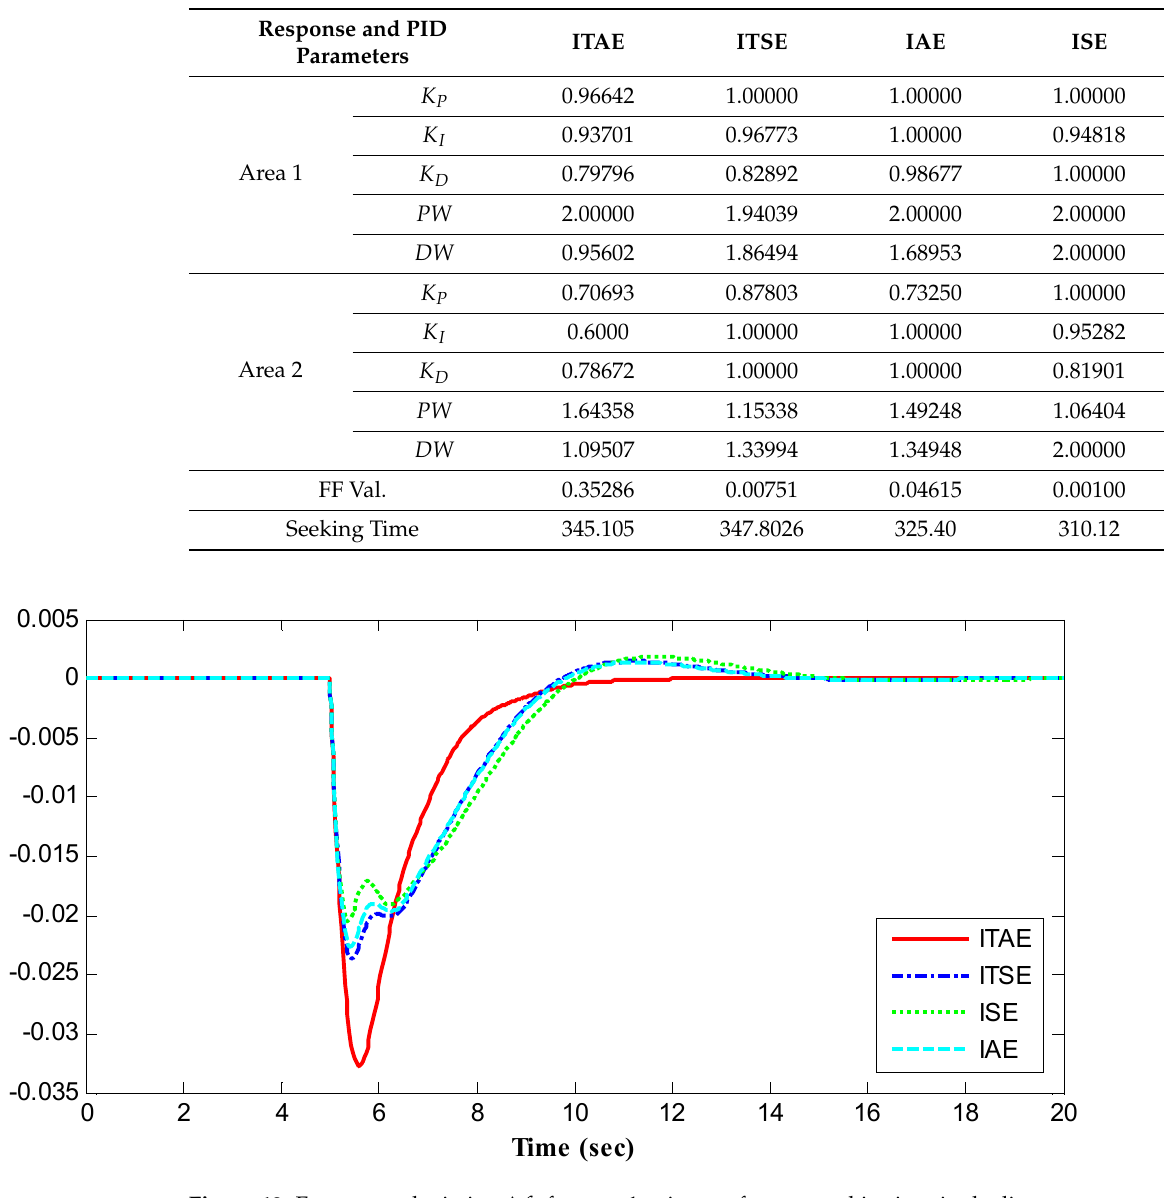
Figure 12. Frequency deviation 𝛥𝑓 (cid:2869) for area 1 using performance objectives in the literature.